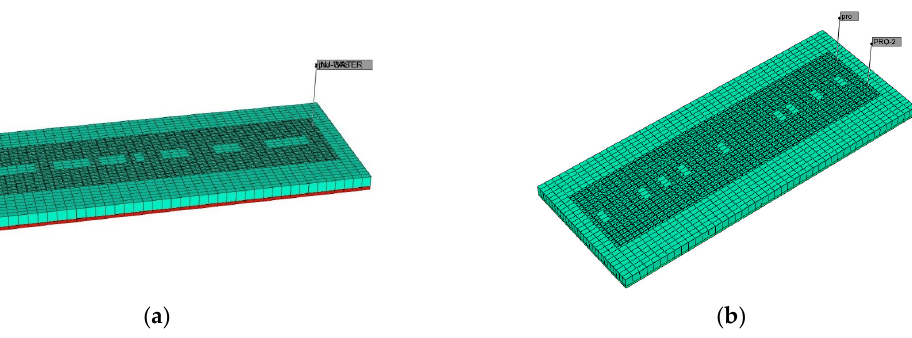
Figure 7. D grid mesh division of numerical models of Scenarios 3 and 4. ( a ) Fracture connectivity of 40%. ( b ) Fracture connectivity of 80%.